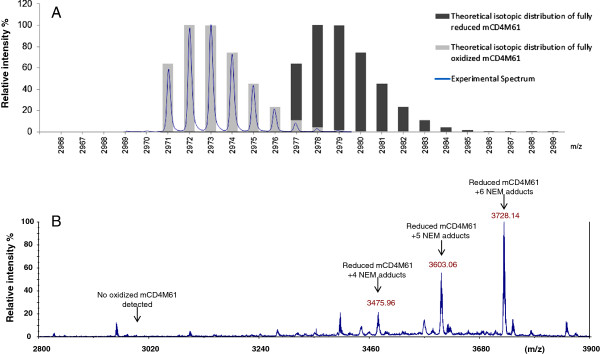
MALDI-TOF analysis of mCD4M61. Panel A: Comparison of the experimental MALDI-TOF spectrum obtained for the mCD4M61 with the theoretical isotopic distributions of fully reduced and fully oxidized mCD4M61. The mCD4M61 DRP was produced using DsbC as fusion partner. Panel B: Experimental MALDI-TOF spectrum obtained for the mCD4M61 using N-Ethylmaleimide as an alkylating agent during cell lysis.